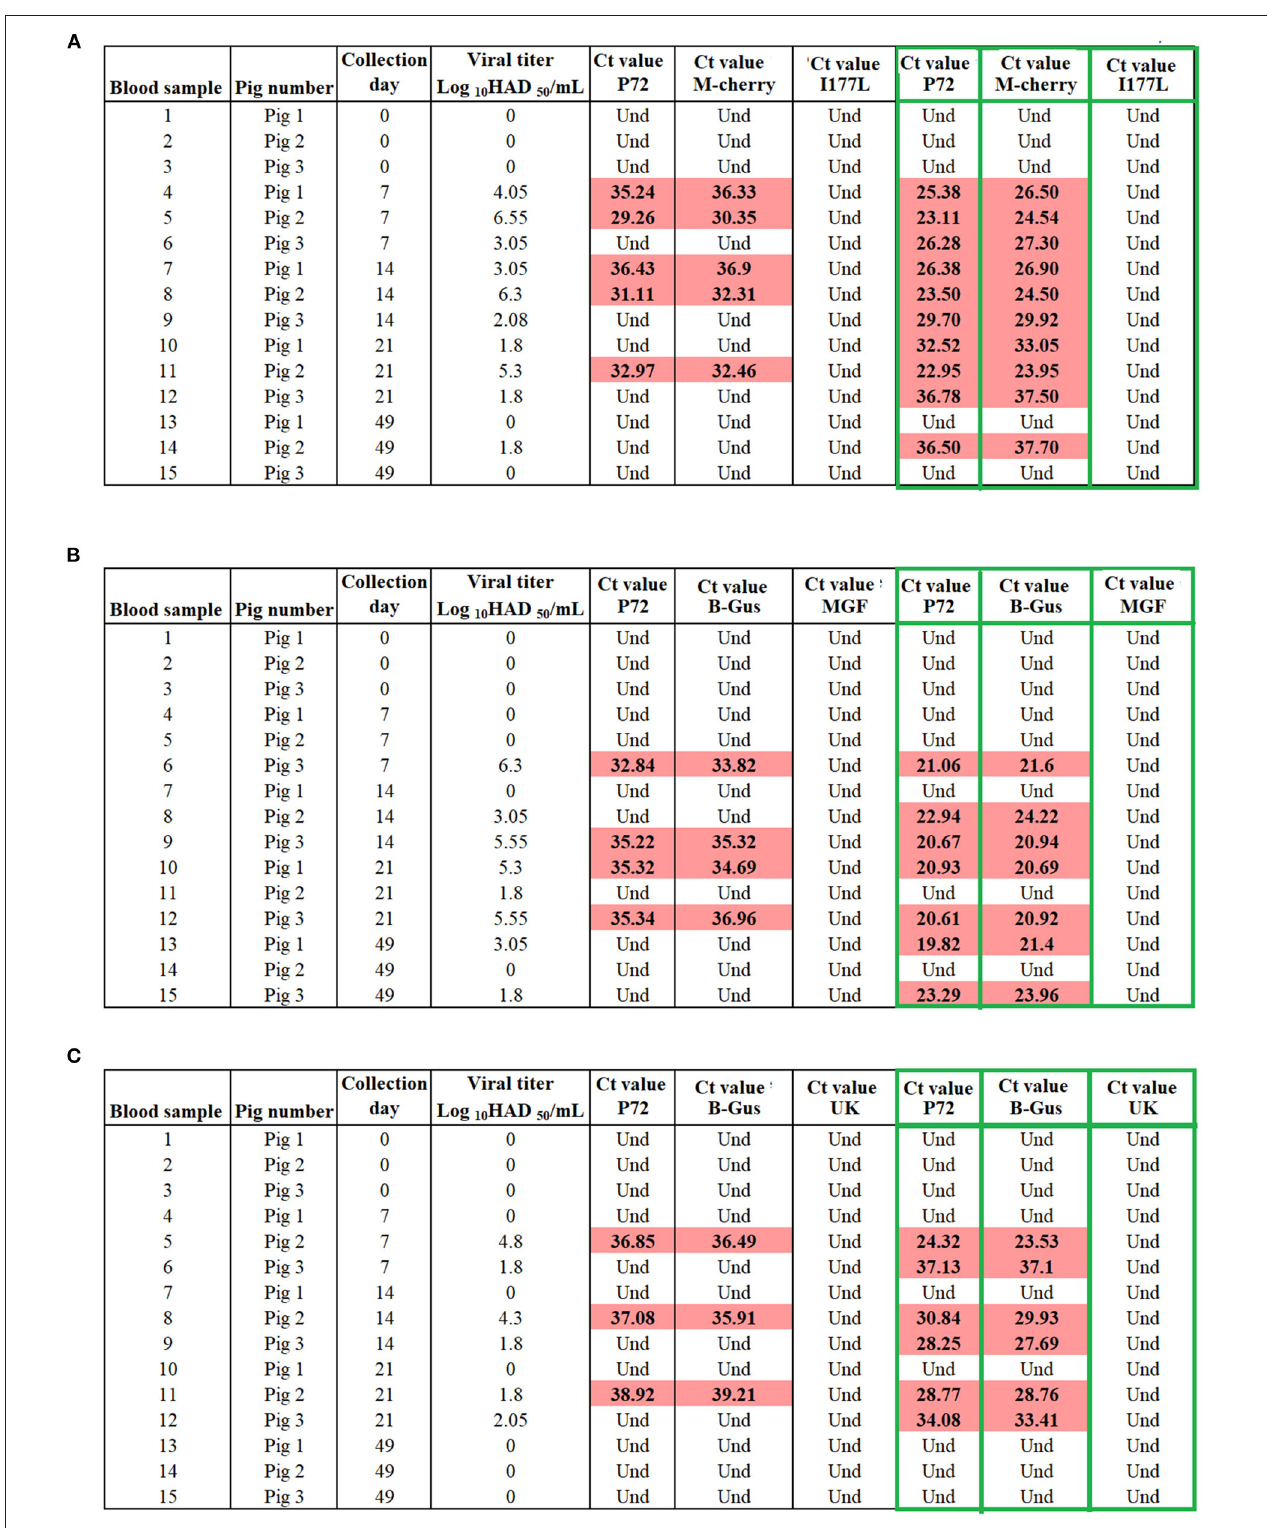
FIGURE 7 | Evaluation the capability of qPCRs to differentiate vaccinated pigs with (A) ASFV- 1 I177L, (B) ASFV-G- 1 9GL/ 1 UK, and (C) ASFV- 1 MGF from those infected with ASFV-G. Blood samples collected from pigs at different time points of vaccination were tested before and after (green boxes) one passage of 72h in swine macrophage cell cultures. M-cherry and β -Gus q PCRs were used for the detection of the recombinant viruses, while p72 assay was used as a marker for the presence of ASFV.